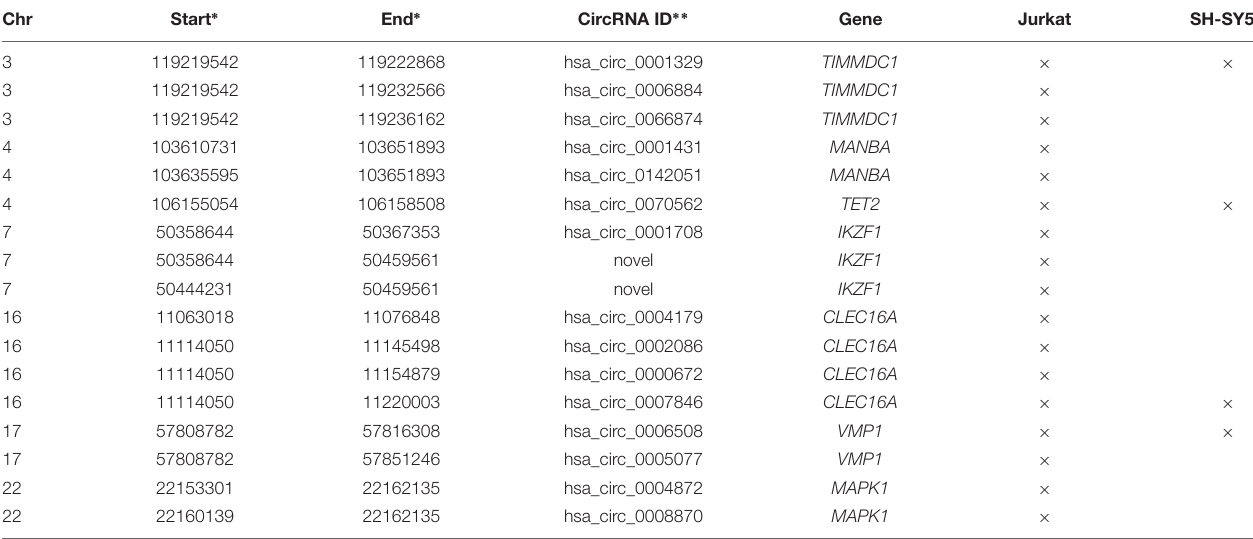
TABLE 3 | CircRNAs identified in Jurkat and SH-SY5Y cell lines within MS-associated genes.